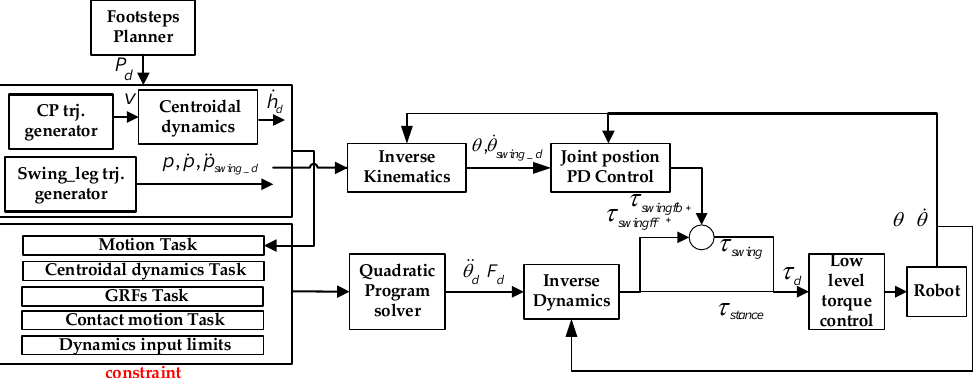
Figure 3. The whole body control system based on centroidal dynamics. P d is the desired footprint from a high level behaviour. v is the desired velocity of CoM. ˙ h d is the desired rate of change of the centroidal momentum. p , ˙ p , ¨ p swing _ d are the desired position, velocity and acceleration of the swing foot in Cartesian space,